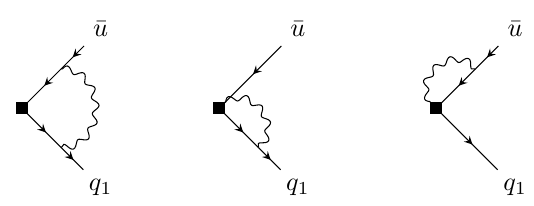
Figure 4 . Diagrams at O ( α em ) that contribute to the anomalous dimensions of the operator